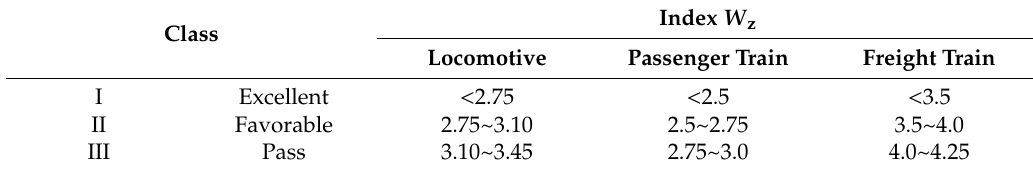
Table 7. Evaluation standards for the vibration acceleration of a train